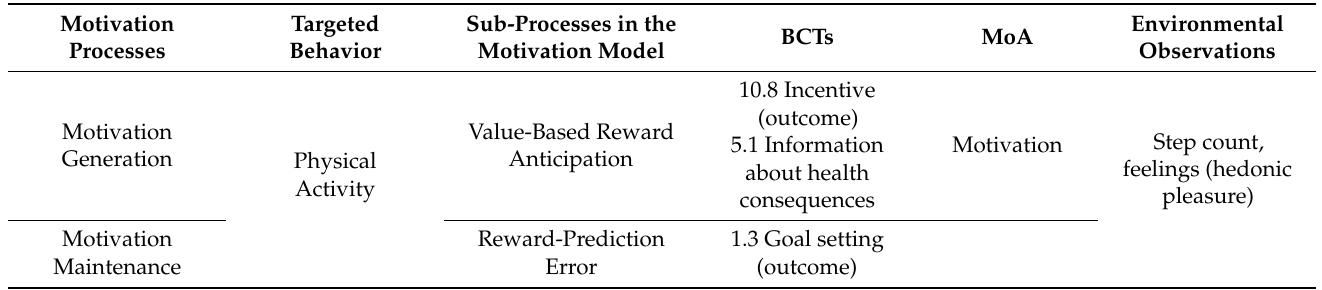
Table 2. Our model defines the intervention components and their relations to specific motivation